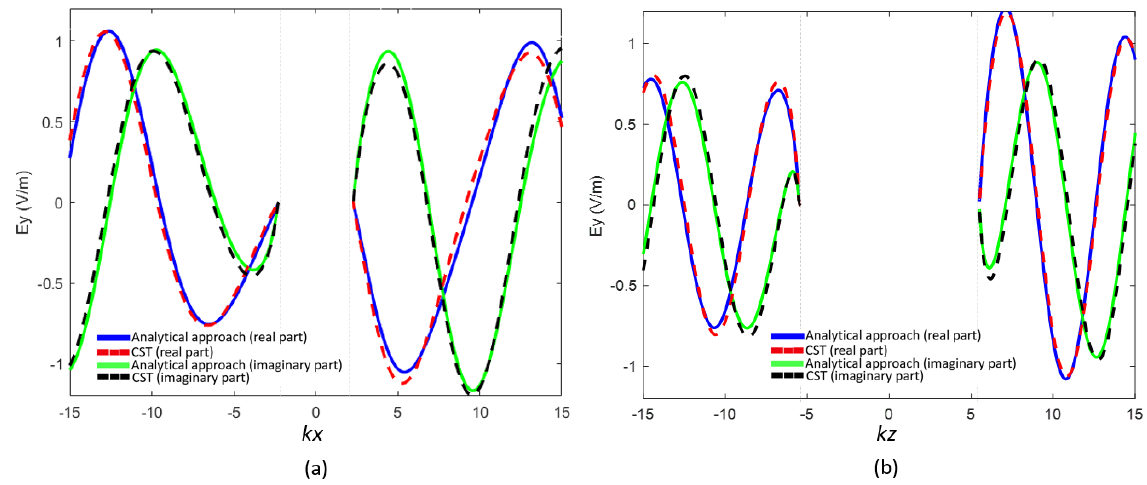
Figure 2. Real and imaginary parts of E y along the x -axis ( a ) and the z -axis ( b ): comparison between results obtained through the analytical approach implemented in Matlab and the results obtained through CST Microwave Studio, for the case θ 0 = 30 ◦ , ka = 5.5, kb = 2.2913, c = 5, ξ 0 = 1.1, d = 10, m t = 9. TE